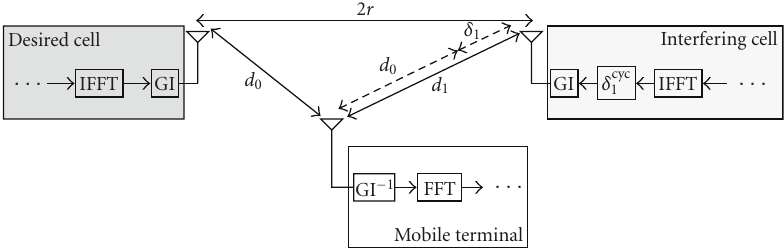
Figure 5: Cellular MC-CDMA system with cellular cyclic delay diversity (C-CDD).